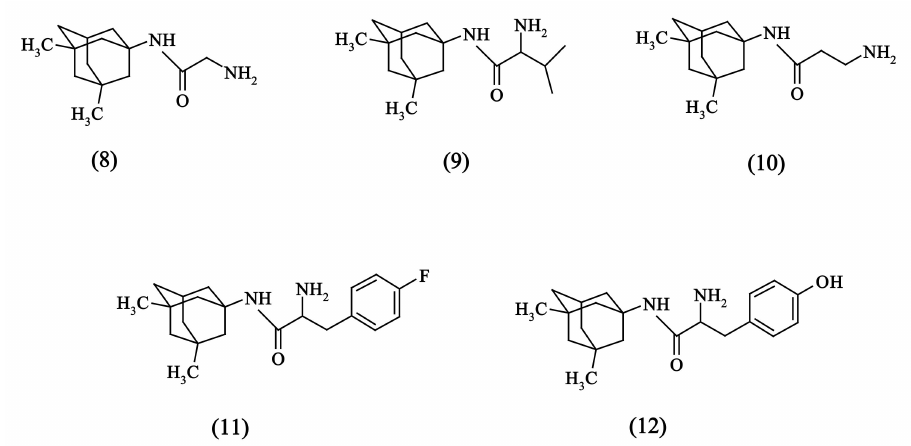
Figure 7. Formulas of the compounds studied in the previous study [30] structurally analogous to the derivatives investigated in the present work (see Figure 2 for the structures): 8 —glycine- memantine; 9 —valine-memantine; 10 —beta-alanine-memantine; 11 —4-F-phenylalanine-memantine; 12 —tyrosine-memantine.